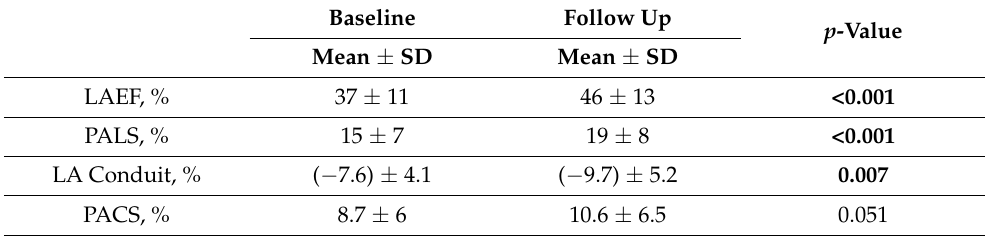
Table 3. Left atrial function parameters.